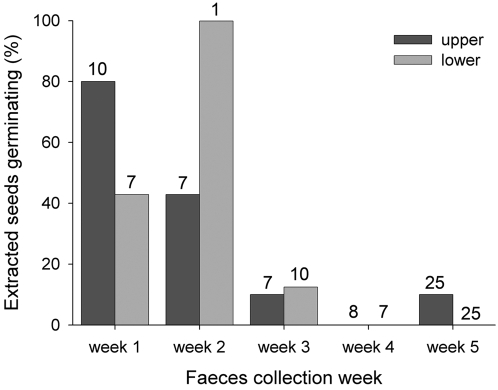
Percentage of tortoise gut-passed seeds germinating in relation to faeces collection week.Numbers above the bars are the number of seeds sown in the forest on the upper and lower plateau, respectively.